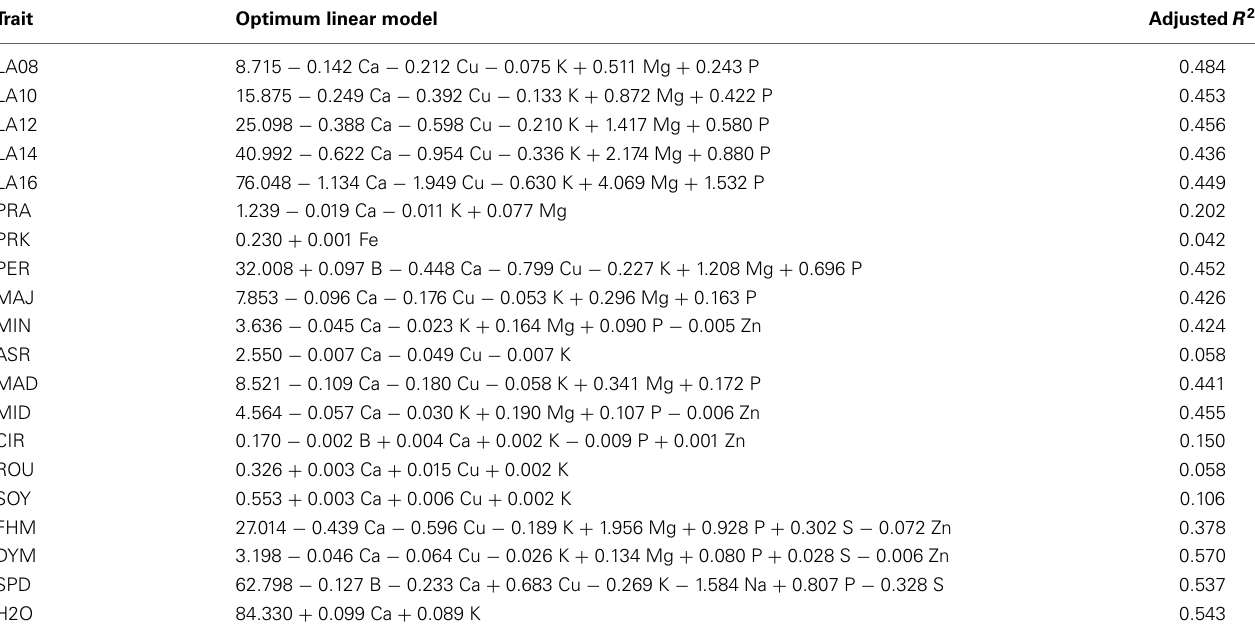
Table 2 | Optimum linear combinations of eleven mineral concentrations describing seedling development traits in 509 B. napus inbreds, and the proportion of phenotypic variation explained by the selected independent variables (adjusted R 2